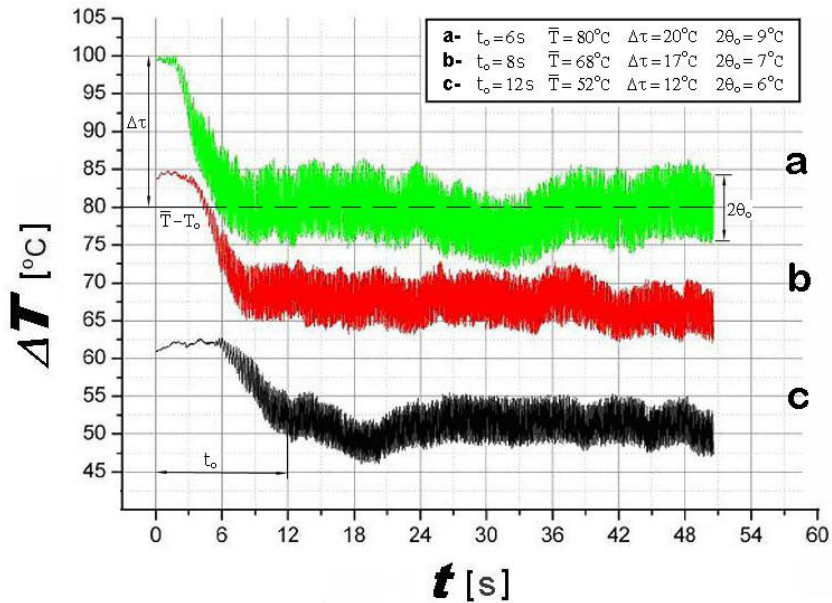
Figure 4. Thermograms of TMO excitations for various initial temperatures T 1 of the fixed heater near the first resonance (excited by varying the pre-stress of the heated wire, i.e., without an external modulator). We display the temperature difference ∆ T ( t ) = T wire ( t ) − T 0 between the heated wire and the surrounding air as a function of time, t . The oscillation in the surrounding air leads to a cooling of the heated wire; i.e., during a characteristic time t 0 , its temperature decreases from T wire ( 0 ) = T 1 to a lower time averaged value T , where the stationary mode oscillation is attained (compare with Figure 3). ∆ τ = T − T denotes the cooling of the wire and θ 0 the amplitude of the temperature pulsations in 1 the stationary mode (with frequencies in the range from 9 to 10 Hz). The frequencies of transverse deflection A was in the range from 4.5 to 4.9 Hz (close to ν 0 , compare with Figure 3). [(Cr20Ni80)-wire of thickness d = 0.35 mm; variable normal stress ∆ σ = 15.3 MPa; modulation depth µ ≈ 10% (ratio of the modulation amplitude and the amplitude of the fundamental oscillation)].